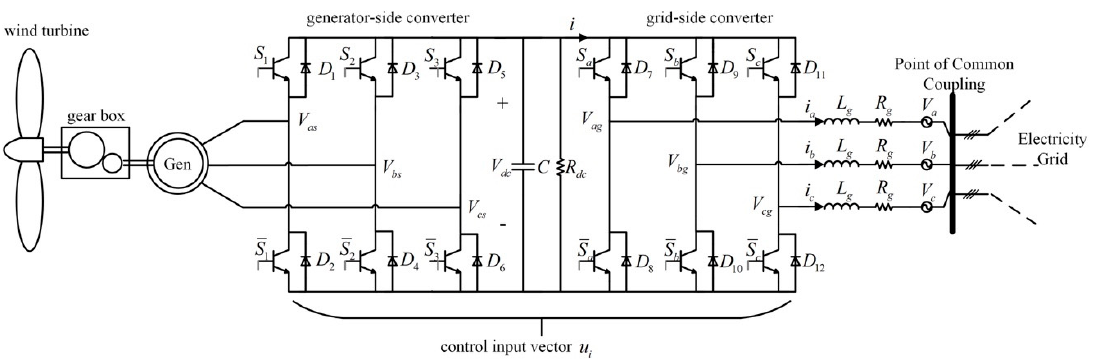
Figure 2. Grid-connected distributed energy resource (DER) unit via power electronic converter.